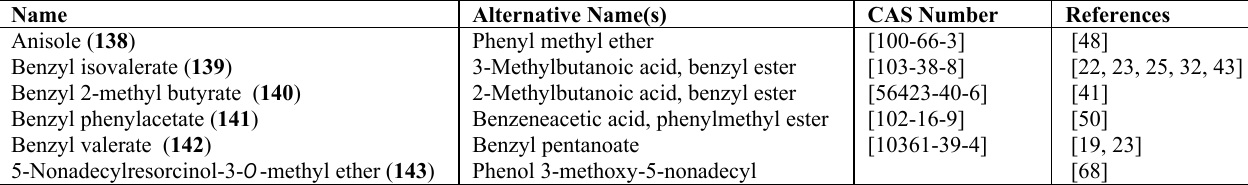
Table 12. Simple Phenols and Benzylic